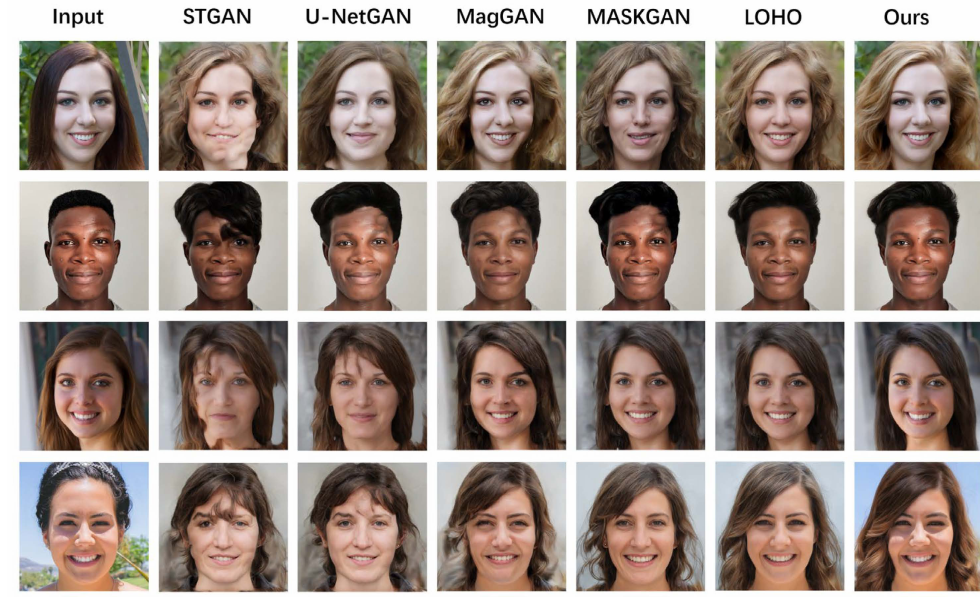
Figure 7. Comparison of the results of our proposed hair generation network model and those of other excellent network